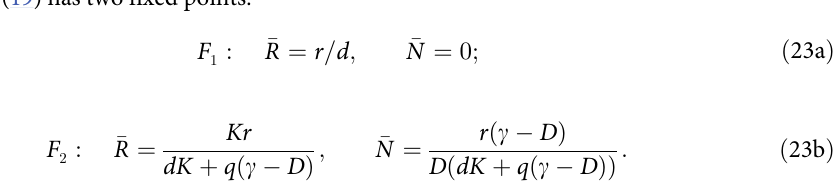
System (19) has two fixed points: